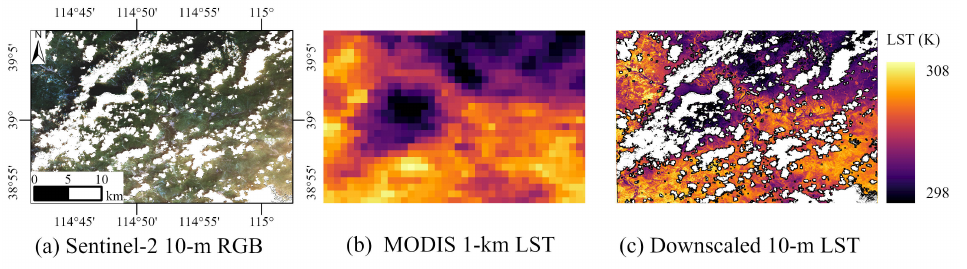
Figure 4. Input data (( a ) 10-m Sentinel-2 RGB, ( b ) 1-km MODIS TIR) and output data (( c ) 10-m downscaling TIR) in downscaling